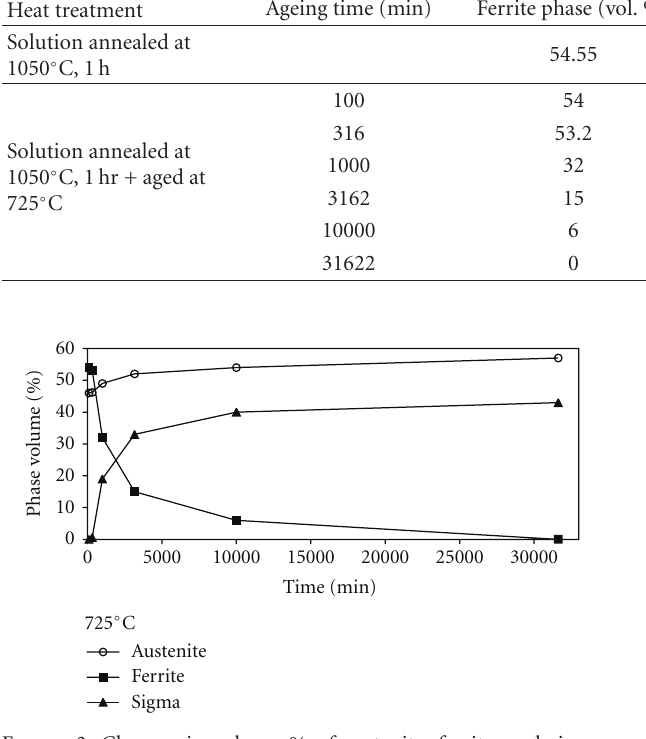
Figure 3: Changes in volume % of austenite, ferrite, and sigma phases with ageing time at 725 ◦ C. Table 3: Weight loss immersion acid test results according to ASTM